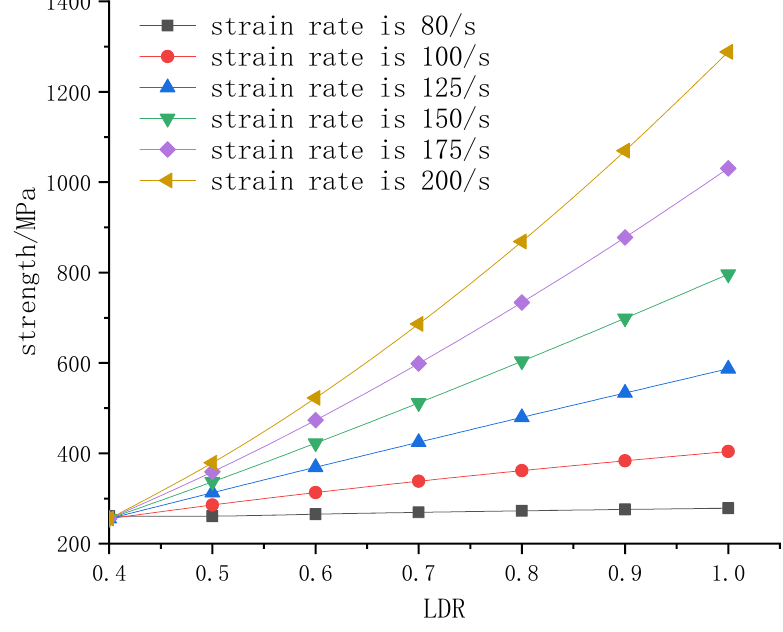
Figure 10. Size effect of dynamic rock strength.